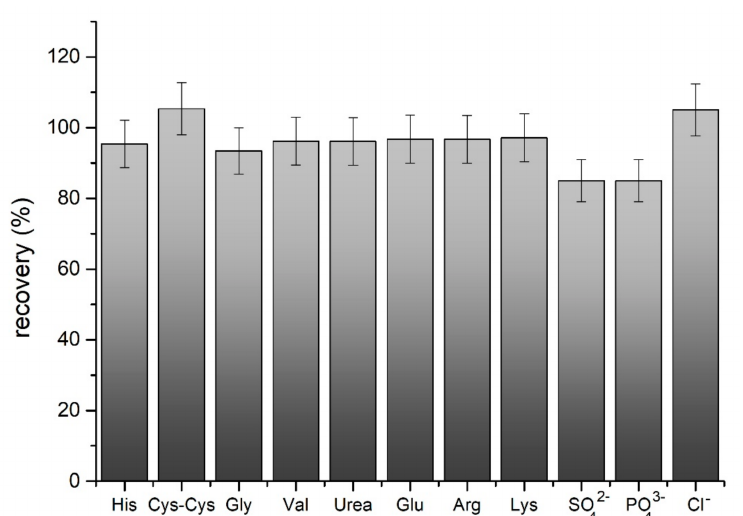
Figure 4. Investigation of interferences from common biomolecules andinorganic electrolytes at physiologically relevant concentration levels. The control sample contains 200 µ M Cys while all other solutions contain 200 µ M Cys and the potentially interfering biomolecule or ion as follows: histidine, glycine, valine, glutamine: 4.0 mM; cystine: 50 µ M; urea: 2.0 mM; glucose: 5.0 mM; Na 2 SO 4 : 12.0 mM; Na 3 PO 4 : 12.0 mM; NaCl: 150.0 mM). All solutions were diluted 4-fold before analysis. Error bars represent the standard error calculated for triplicate